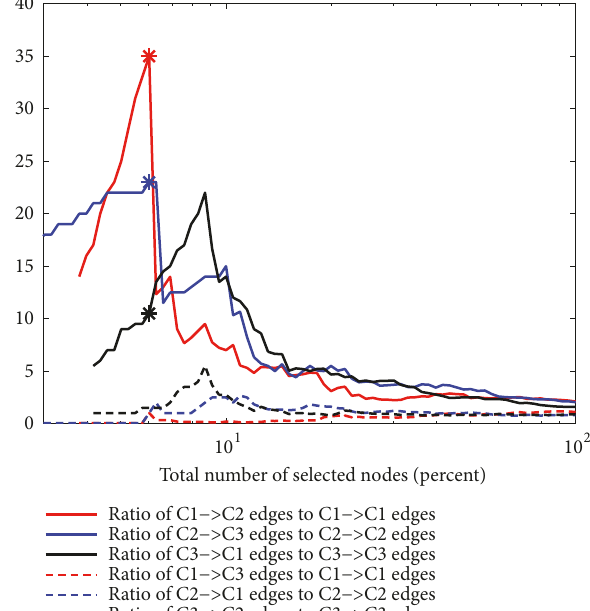
Figure 18: The ratio of the number of edges going from cluster X to cluster Y to the number of edges inside cluster X depending on the percentage of nodes in all clusters for Gnutella network. Cluster X can be cluster C1 or cluster C2 or cluster C3 and cluster Y can be cluster C1 or cluster C2 or cluster C3. The asterisk shows the point where the sum of three ratios plotted as solid lines is the maximum.